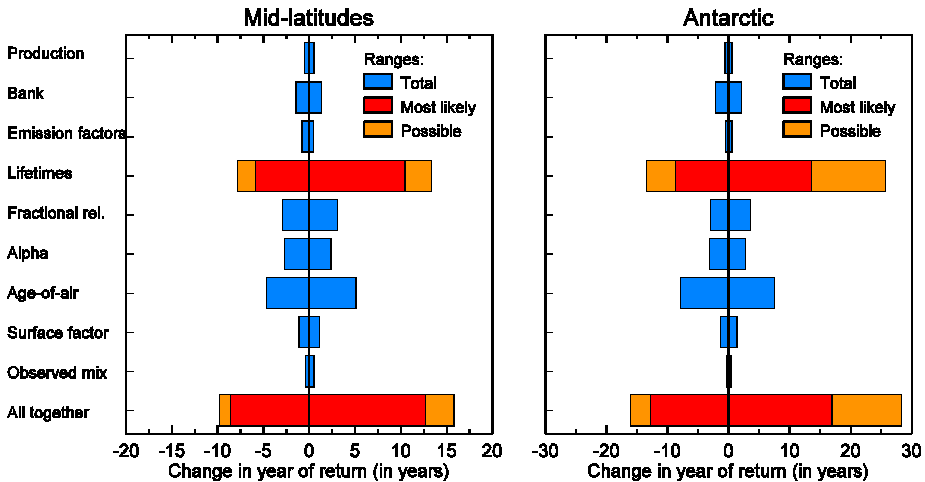
Figure 7 Fig. 7. Uncertainties (difference from the median, 95% confidence interval) in the years of return to pre-1980 levels for midlatitude and Antarctic springtime conditions resulting from uncertainties in all considered model input parameters. The year of return in the base run is 2048 for midlatitudes and 2075 for Antarctic spring